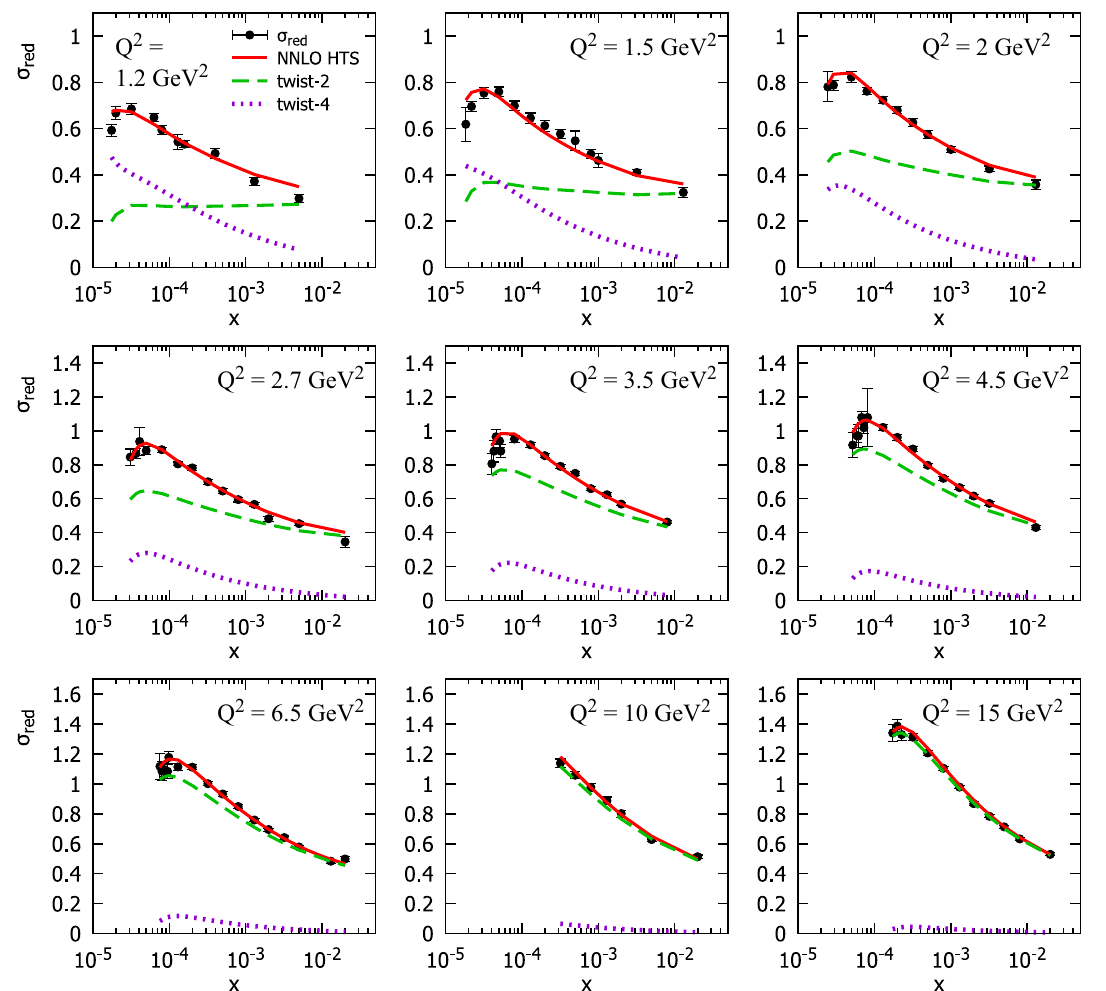
Fig. 5 The combined low- Q 2 HERA inclusive NC e + p reduced cross sections compared to the NNLO HTS fits (full red line). Also shown twist 2 (dashed green line) and twist 4 (dotted purple line) contributions